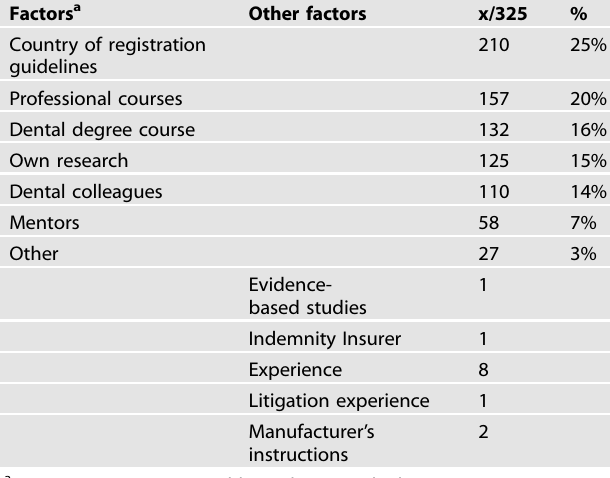
Table 3. Factors affecting practitioner perception of dental local